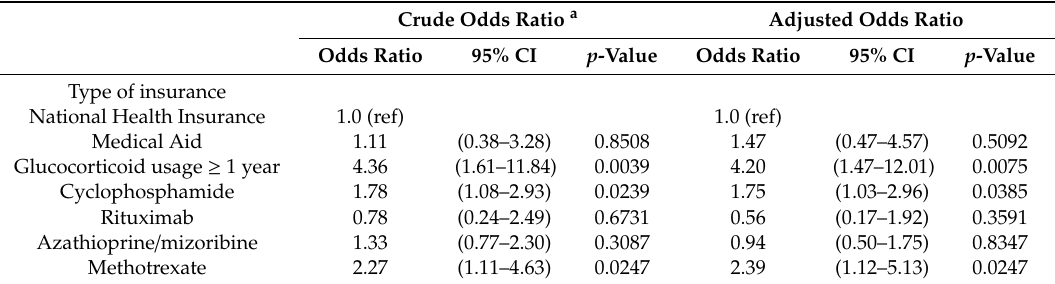
Table 5. Factors associated with the development of cancer among patients with